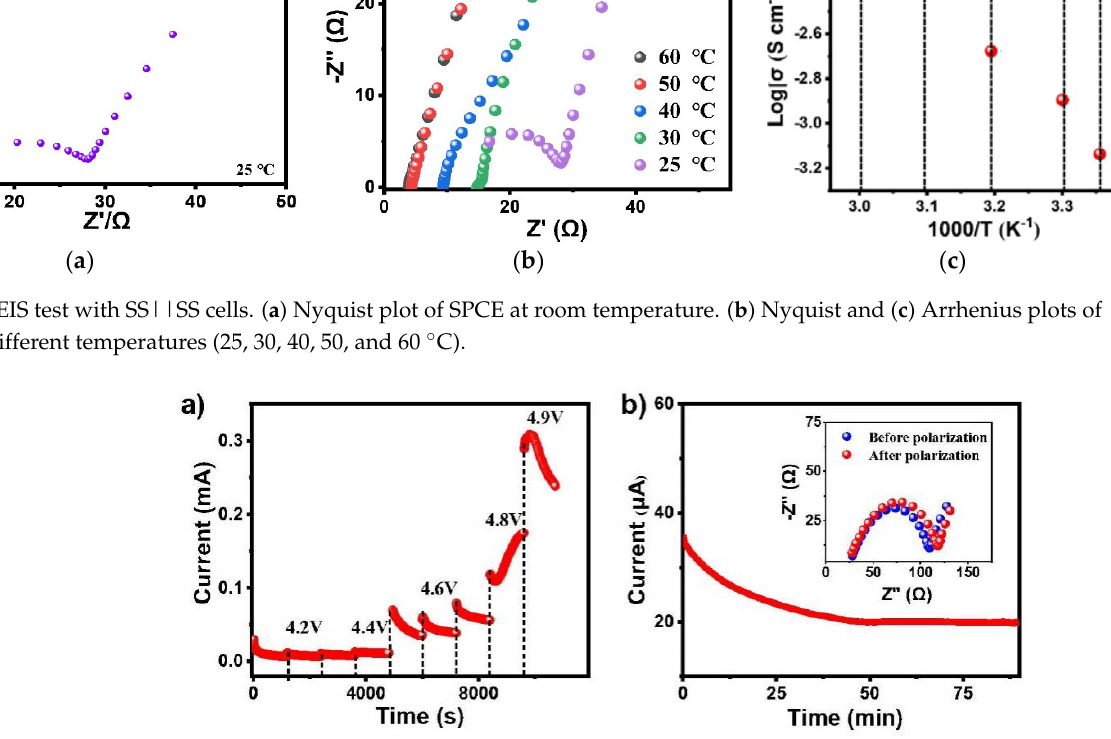
Figure 4. ( a ) Electrochemical floating analysis of SPCE with SS||Li cell. ( b ) Current–time curve and EIS plots before and after polarization of SPCE with Li||Li symmetric cell.